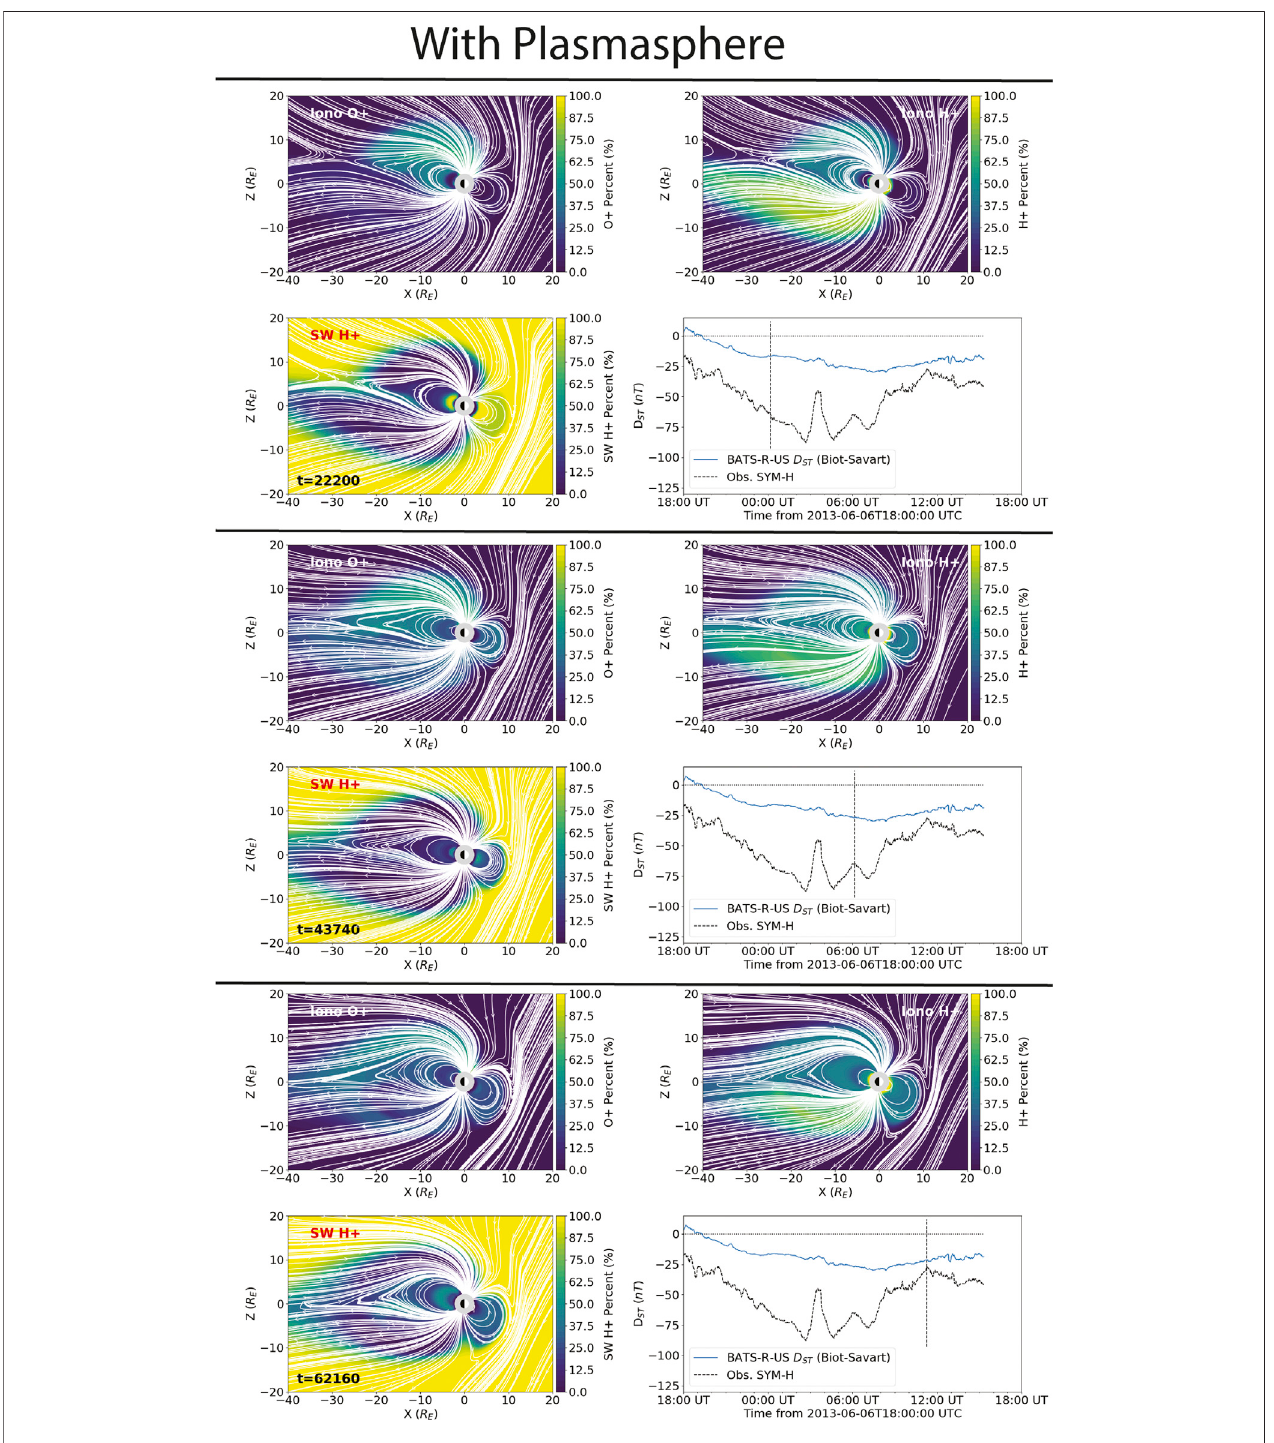
FIGURE 12 | Results of a merged multi- fl uid model of a storm period showing the relative contributions of the ionosphere and solar wind to the magnetosphere.